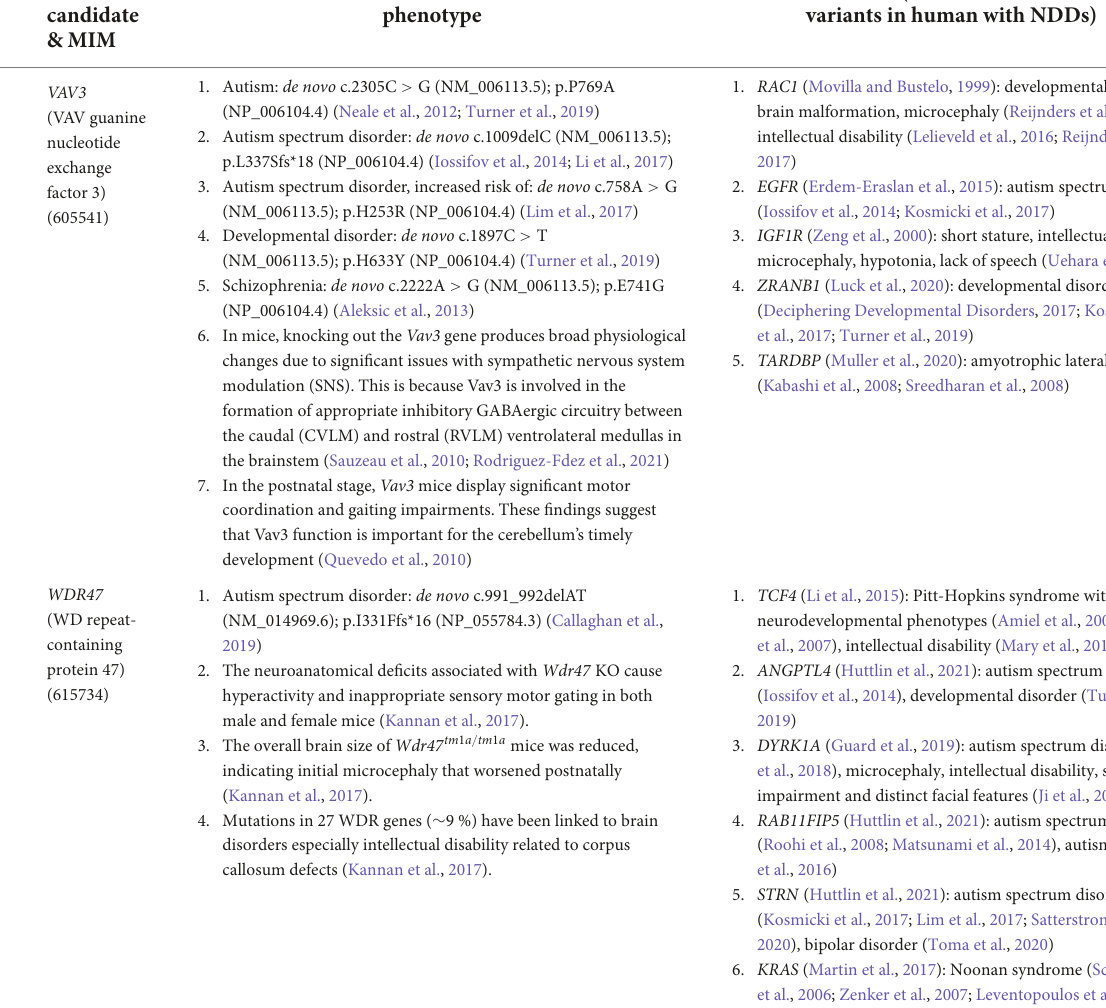
TABLE 2 Five positional candidate genes for syndromic NDDs identified by in silico CNV mapping at 1p13.3. No. Variants in human and KO mice with NDDs Protein interactors (references for interaction and phenotype variants in human with